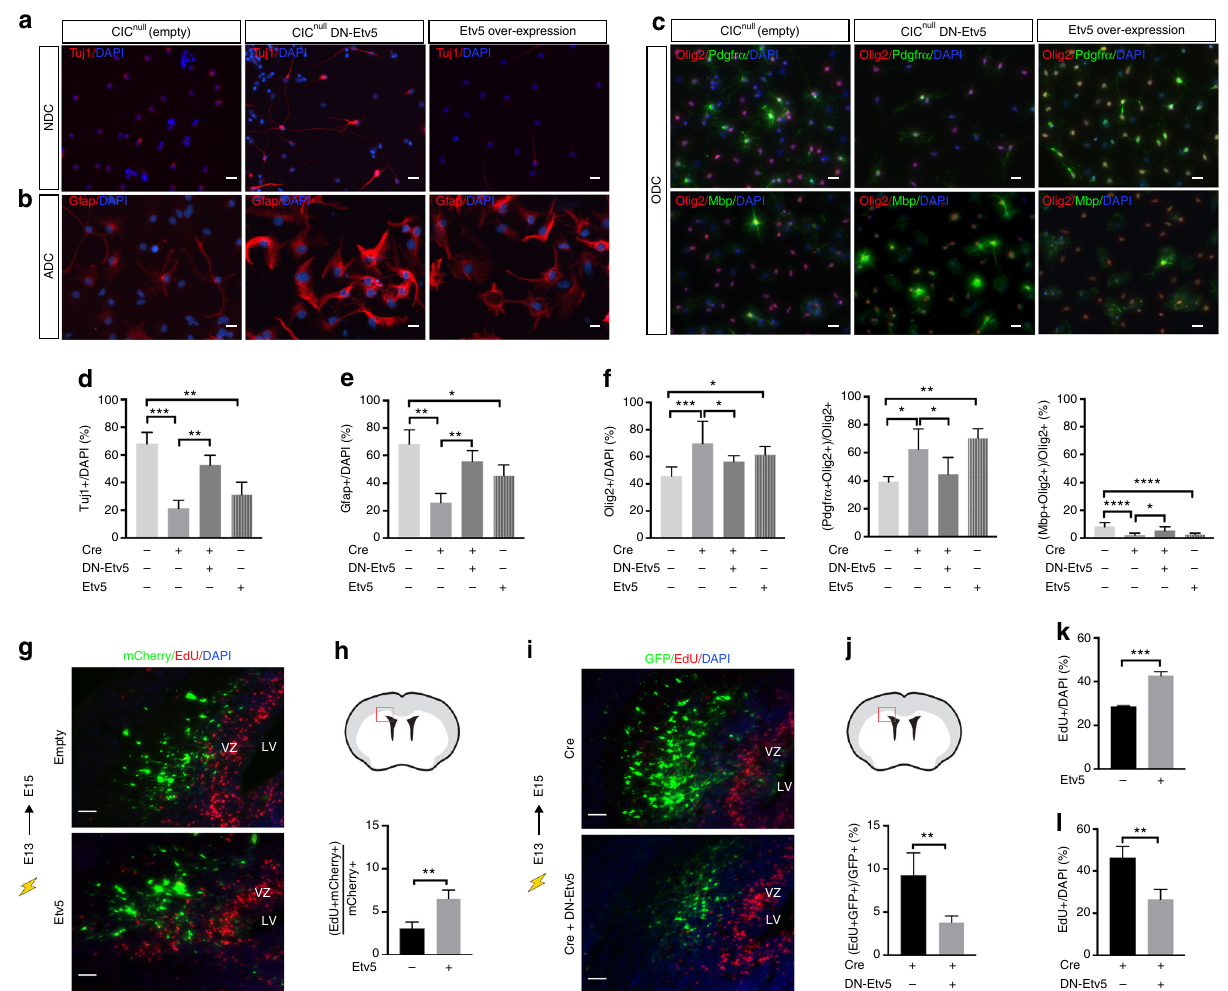
Fig. 8 Etv5 is necessary and suf fi cient for proliferation and cell fate bias downstream of Cic loss. a – f Cic - null NSCs (Cic null Empty), Cic - null NSCs with dominant negative Etv5 (Cic null DN-Etv5), and Cic-wildtype NSCs overexpressing Etv5 (Etv5 overpression) were grown in lineage-directed culture conditions and assessed for their ability to differentiate to neurons, astrocytes, and oligodendrocytes as determined by immunostaining for bIII-Tubulin (Tuj1), Gfap, and Olig2, Pdgfra, and Mbp. Scale bar: 10 μ m. Analysis of Tuj1 + cells from NSCs in neuronal differentiating condition, NDC a , d ; analysis of Gfap + cells from NSCs in astrocytic differentiating condition, ADC b , e ; and analyses of Olig2 + , Pdgfra + , and Mbp + cells from NSCs in oligodendrocyte differentiating condition, ODC c , f from n = 3 biological replicates, with three technical replicates each, for cell culture studies. g , h Representative images and quantitation of EdU incorporation 2 days post electroporation of wildtype ETV5 or empty control plasmid, both carrying mCherry as a marker, into